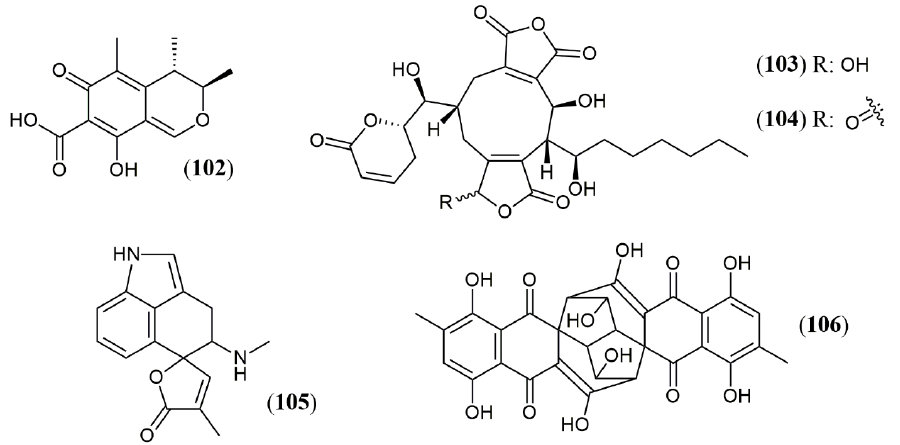
Figure 10. Chemical structures of mycotoxins citrinin ( 102 ), rubratoxins A ( 103 ) and B ( 104 ), rugulovasins ( 105 ) and luteoskyrin ( 106 ) [74].